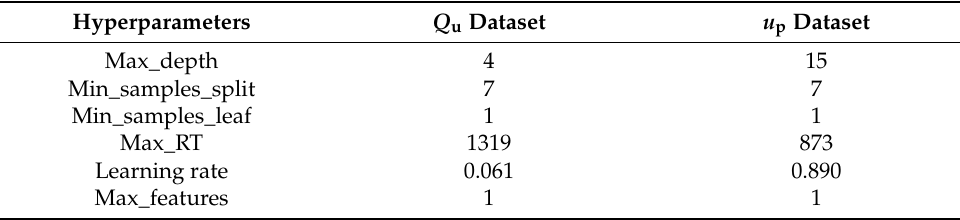
Figure 6. Comparison of model performance before and after hyperparameter tunning. Table 5. Optimized hyperparameters for both